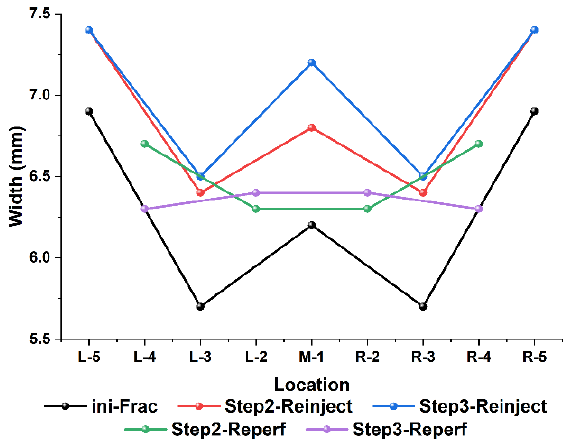
Figure 14. Fracture width of different fracturing methods.